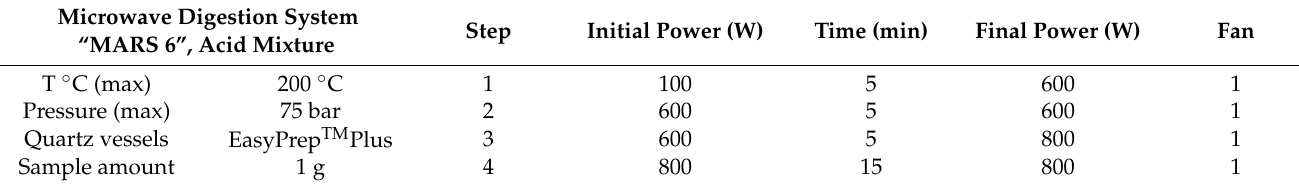
Table 2. Microwave digestion system general and operational parameter.